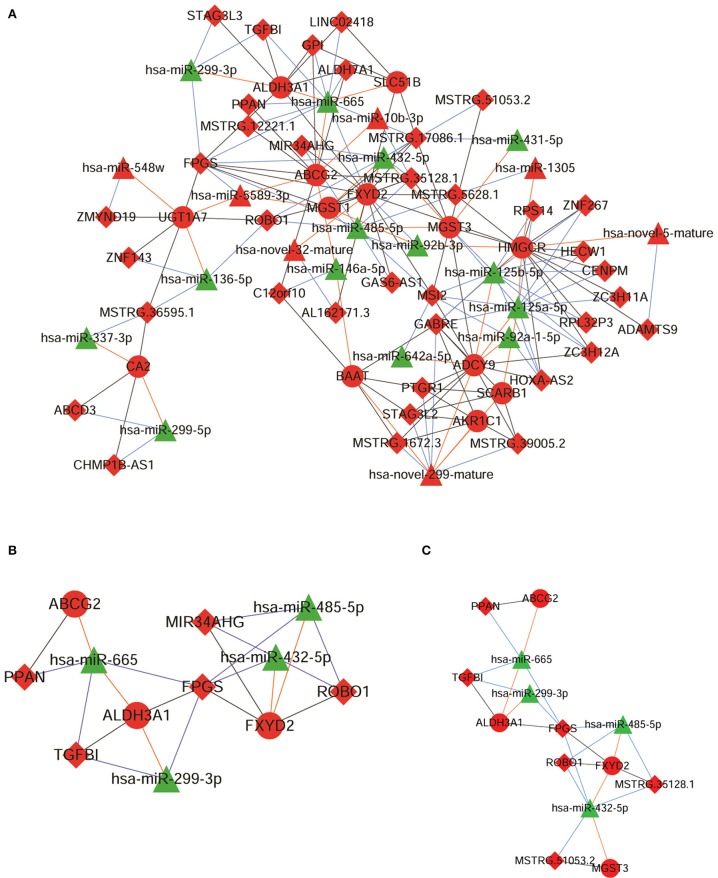
The competing endogenous RNA (ceRNA) networks constructed using (A) 13 messenger RNAs (mRNAs), (B) 4 mRNAs, 5 long non-coding RNAs (lncRNAs), and 4 micro RNAs (miRNAs), and (C) 6 lncRNAs and 4 miRNAs. Red nodes represent up-regulated expression, green nodes represent down-regulated expression, triangular nodes represent miRNA, circular nodes represent mRNA, and diamond nodes represent lncRNA.